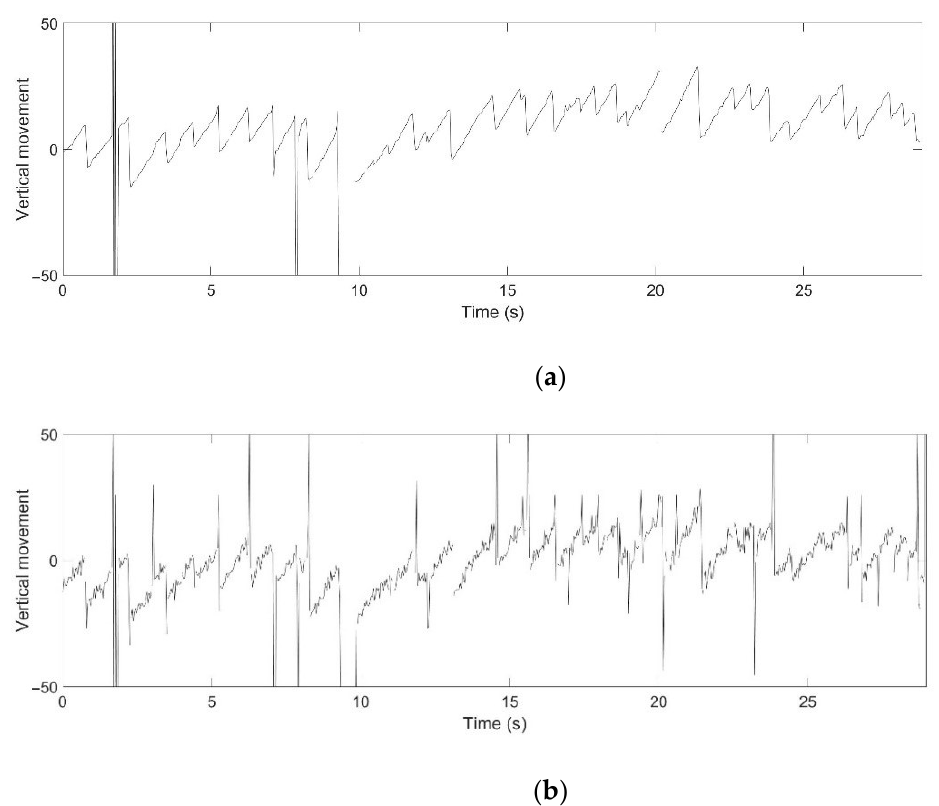
Figure 16. Sample of a video frame from Video No. 2.